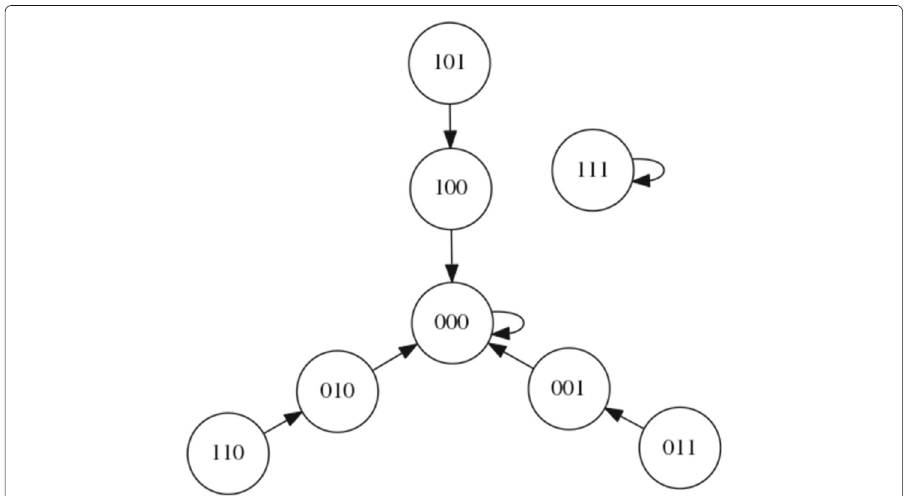
Fig. 3 State space of the simple Boolean network with all nodes using the AND logic